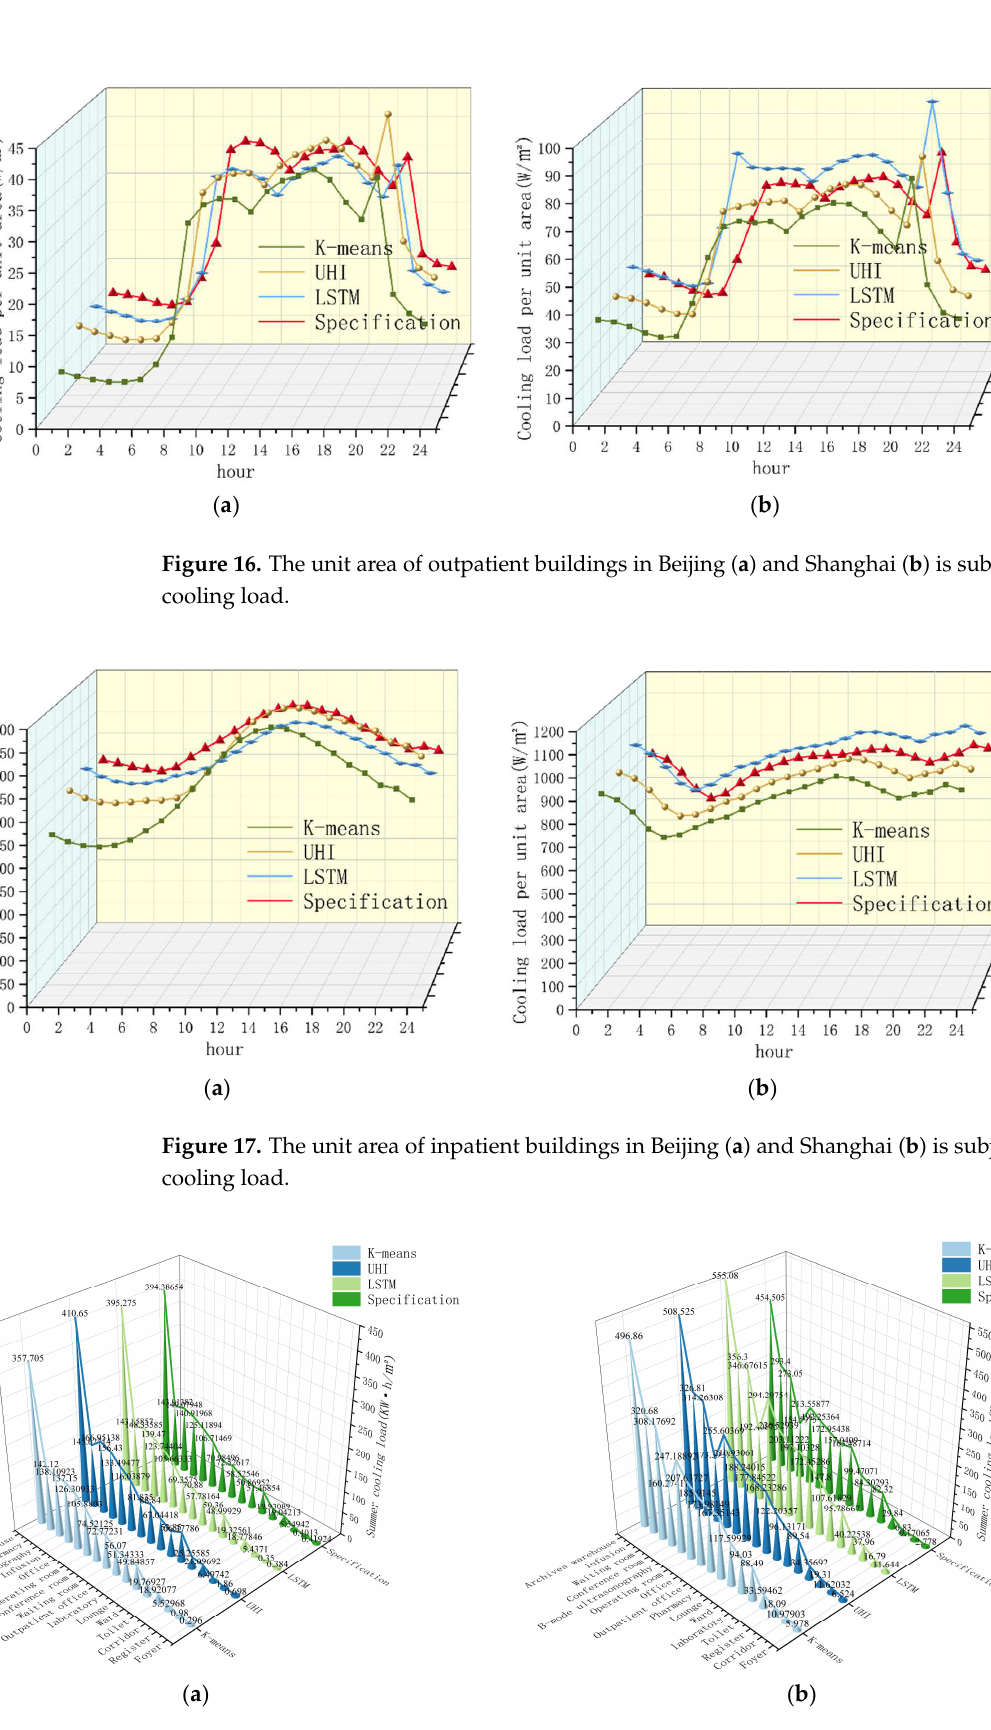
Figure 18. Statistics of summer cooling load in Beijing ( a ) and Shanghai ( b ) outpatient buildings.